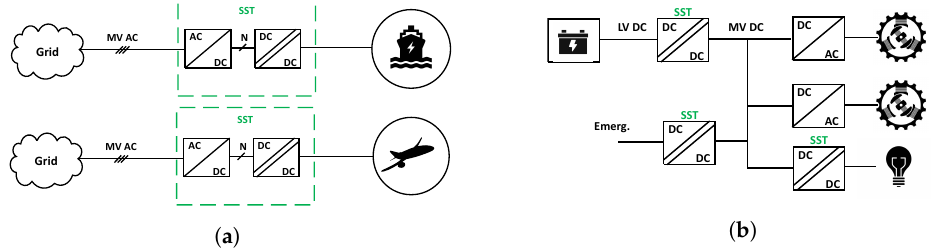
Figure 12. ( a ) Maritime and aerospace high voltage electric chargers based on SST technology. ( b ) SST example acting as onboard system for maritime or aerospace applications.